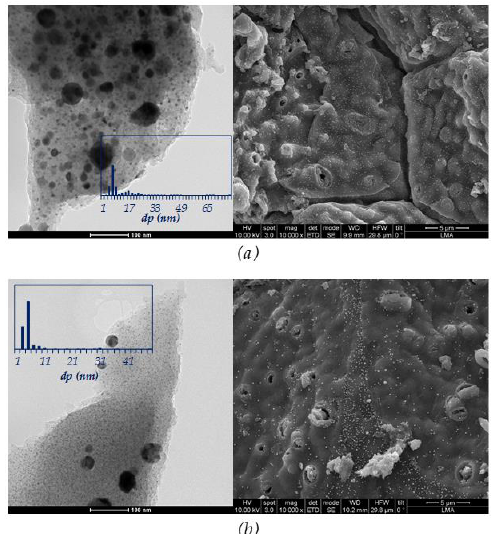
Figure 2. Electron microscopy study of the fresh catalysts: ( a ) Ni – Cu/ArDC ( b ) Co – Cu/ArDC.